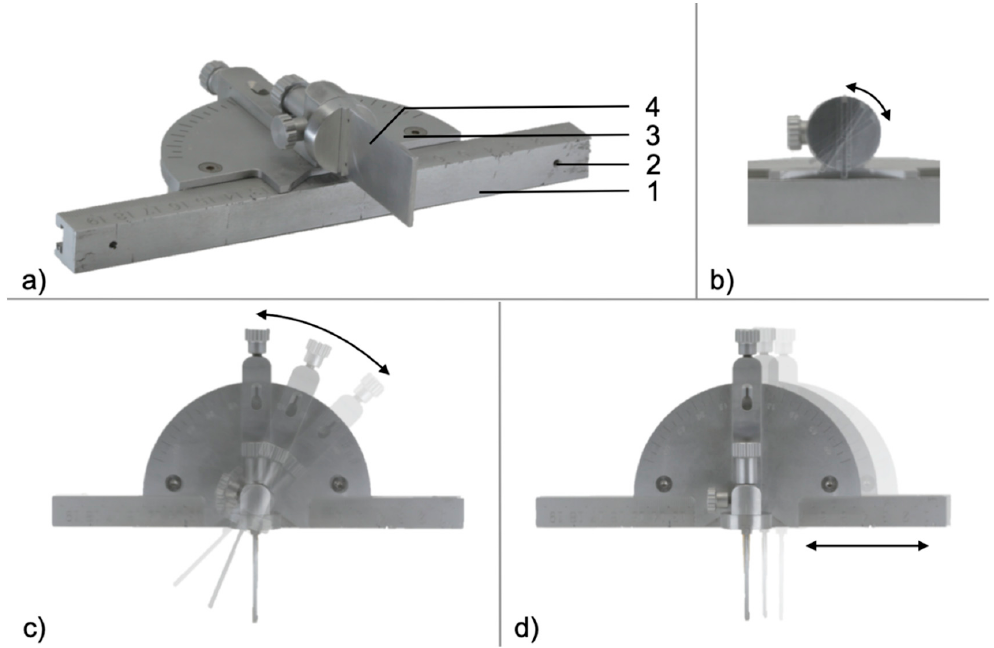
Figure 1. Diagonal view of Multi-Use Cutting Jig (MUC-Jig) ( a ). Ruler-rail (1), which can be attached to the fibula with two standard screws (2). The angle gauge (3) can be adjusted vertically ( b ) and horizontally ( c ) and can be moved along the ruler-rail ( d ). The stop (4) guides the saw blade intraoperatively over a distance of 25 mm, which provides a high degree of stability.